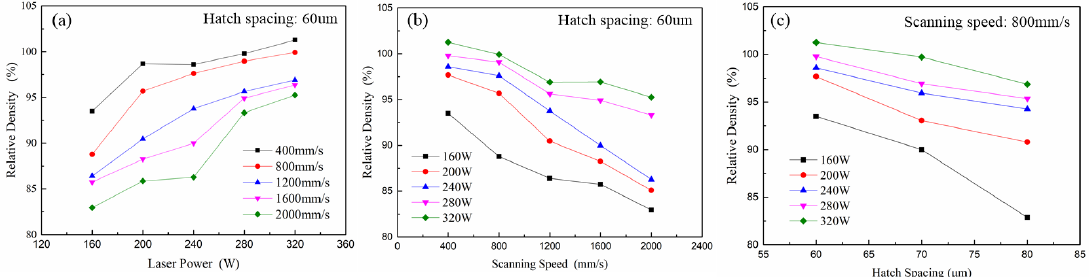
Figure 8. The influence of the process parameters on the relative density of the SLM specimens: ( a ) laser power, ( b ) scanning speed, and ( c ) hatch spacing.